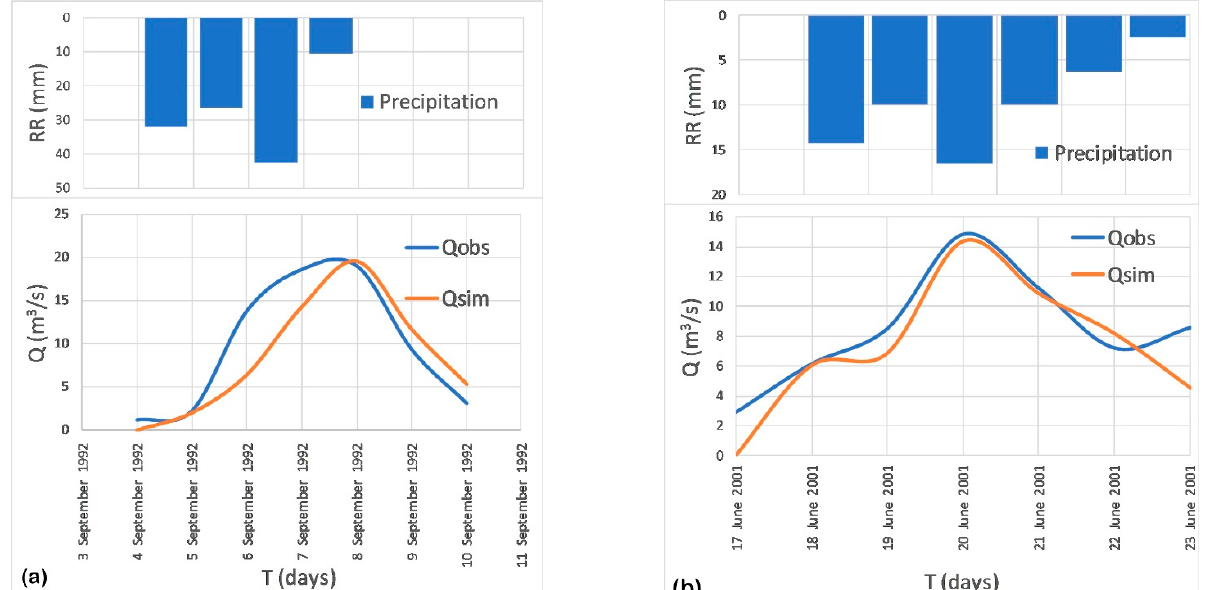
Figure 10. Isolation of an event on the hydrograph: ( a ) 1992 and ( b ) 2001. The average altitude of the basin and its location favor a long snow cover duration, usually from October to May, but sometimes it extends even into June. The high peak flow of March–April is well above the value of the simulated flow, due to the large amount of snow accumulated during the winter and which begins to melt in April. The situation is somewhat opposite starting from autumn, when the simulated flow values are higher than the observed ones. This situation may be explained by the large amount of precipitation falling and accumulated as a snow layer in the high mountains. The climatic parameter temperature plays an extremely important role in this case; therefore, the model cannot correctly simulate the events that took place during the winter season. Under these circumstances, for model calibration, we selected events only from the warm season (June to September) when the influence of snow melting and deposition is absent. A difference can be observed between the simulated and the observed values (Figure 10). The causes can be multiple, but the most important seem to be the uncertainties re- garding the spatial and temporal variation in the precipitation value, as well as the initial humidity state of the basin; further, the structure of the model can be suspected as a cause, which is too simple. The generalized SCS model used is the only model that captures the influence of vegetation on runoff, using only two parameters for calibration (lag time, CN). The daily precipitation value contained in the gridded dataset does not allow the detailed capture of the rainfall–runoff response. Although the shape of the simulated dis- charge hydrograph does not precisely follow the observed one, the overall accuracy of the amplitude and phase of the discharge hydrograph fall under the accepted and recom- mended thresholds, which confirms the reliability of the model for testing the proposed methodology. The main purpose of this analysis is to calculate the influence of the forested area on the runoff and not a rigorous analysis of the precipitation–runoff phenomenon.